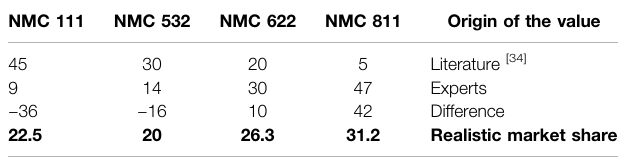
Table 2 | Battery life in fl uencing factors and their development forecast. In fl uencing factors